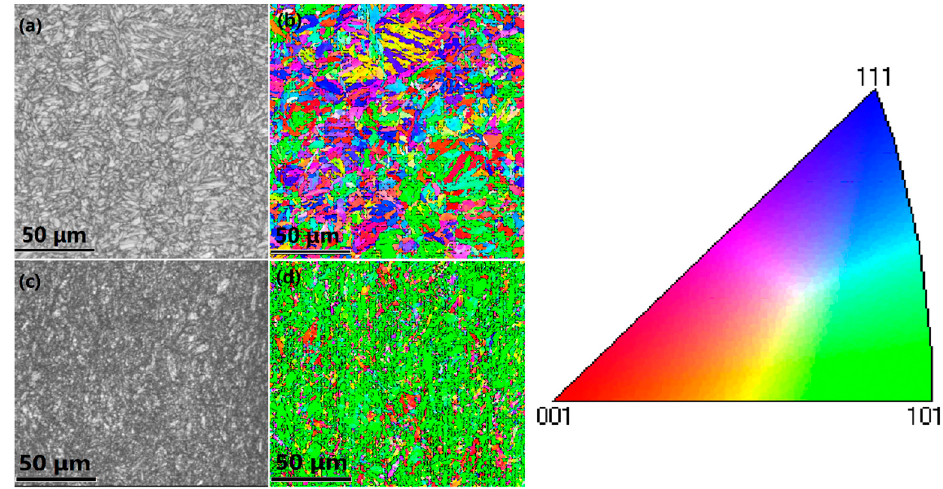
Figure 9. SEM and EBSD morphologies. ( a , c ) before rolling, ( b , d ) after rolling.